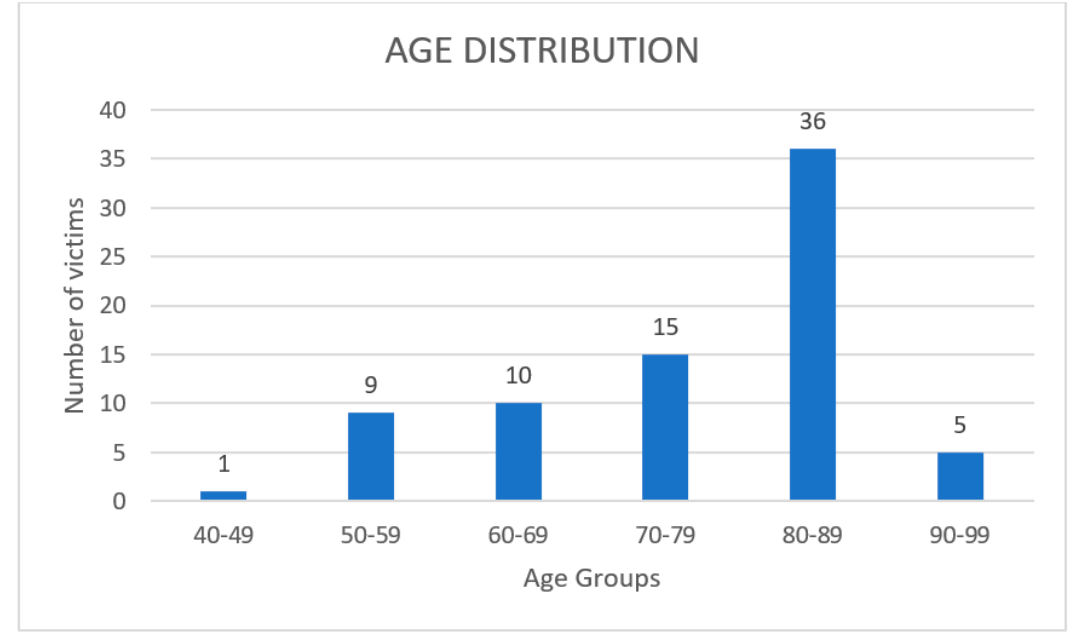
Figure 4. Age distribution of the study group #1.